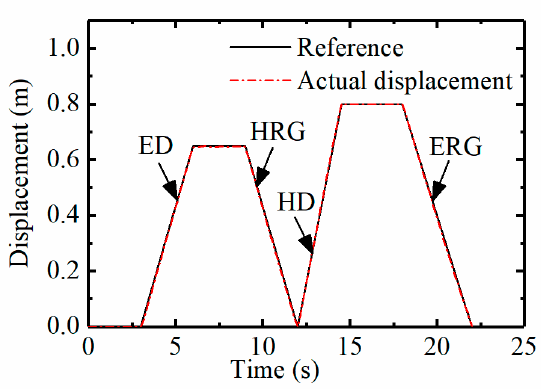
Figure 5. Piston Displacement Curve.